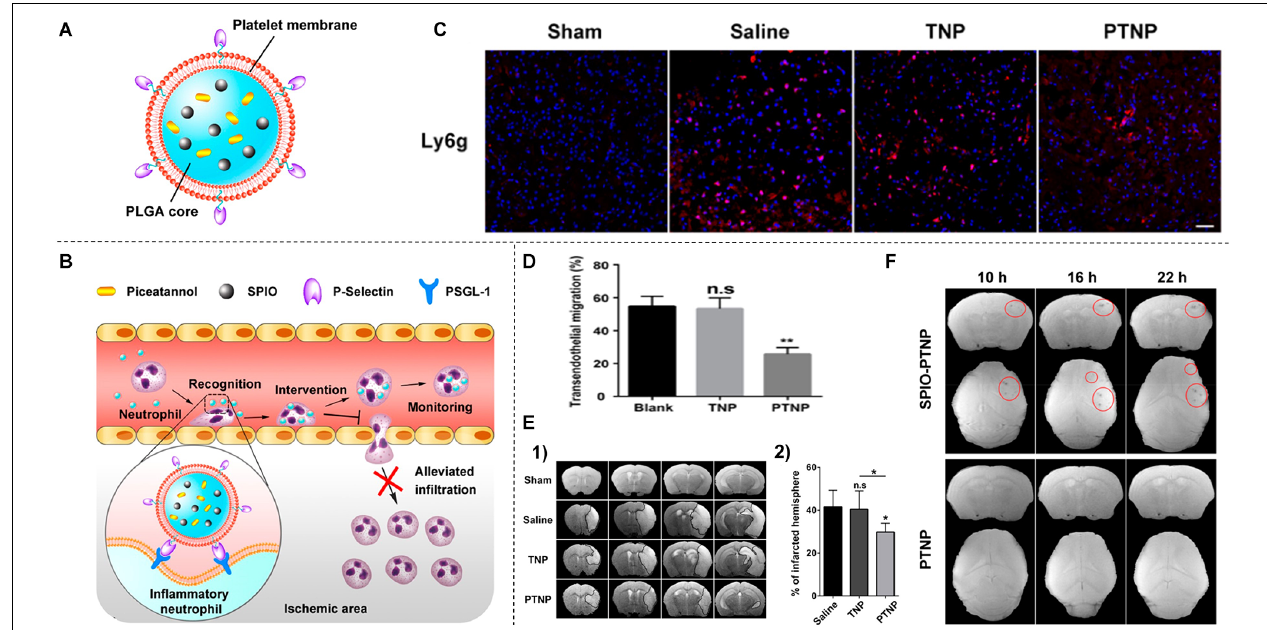
FIGURE 2 | (A) Schematic diagram of PTNPs-based multifunctional nanoparticles. (B) Selective recognition of inflammatory neutrophils by PTNPs and the subsequent reduction of neutrophil infiltration. (C) CLSM images of neutrophil infiltration in the ischemic brain region after treatment with saline, TNPs, and PTNPs. (D) Percentage of neutrophils to pre-existing neutrophils after intervention with TNPs or PTNPs. (E) T2-weighted images of the ischemic brain at 24 h after treatment with saline, TNPs, and PTNPs hou. The black curve indicates the infarcted area (1) and quantitative results of infarct volume (2) . (F) T2*-weighted coronal and cross-sectional scan images at different time points after injection of SPIO-PTNPs and PTNPs. * P < 0.05; ** P < 0.01; n.s means no statistically significant difference. Reprinted (adapted) with permission from Tang et al. (2019). Copyright 2019 American Chemical